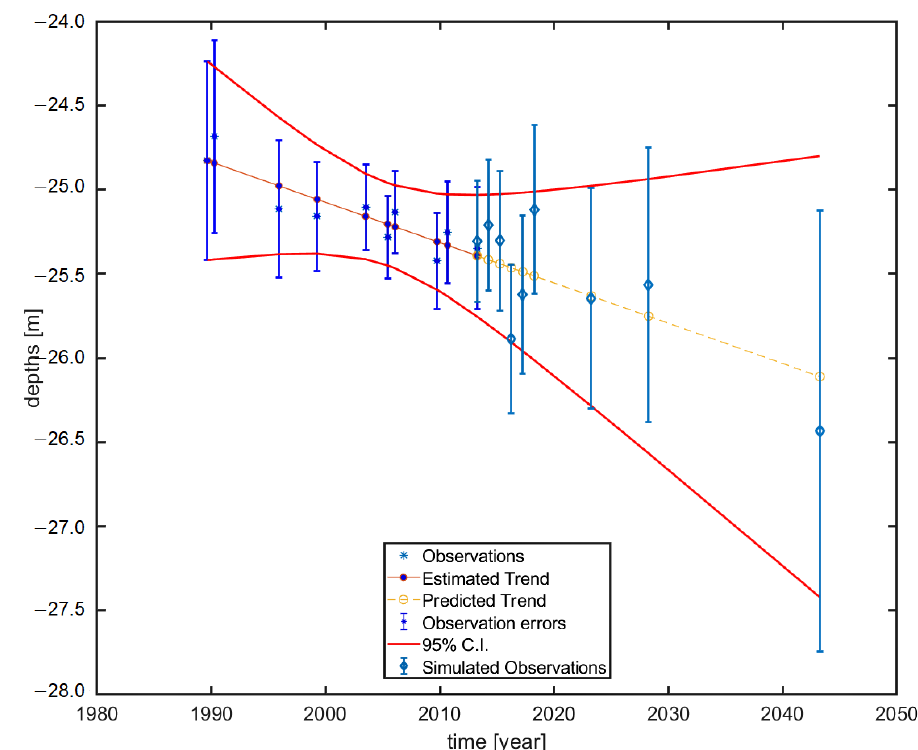
Figure 6. Example showing the simulated observations z ( S + 1 ) at last survey moment t S and predicted times, t S + 1 where T (years) is [1 2 3 4 5 10 15 30] using the forward model or estimated trend (BLUE) in relation to the observed depths, d and predicted trend, including the 95% confidence